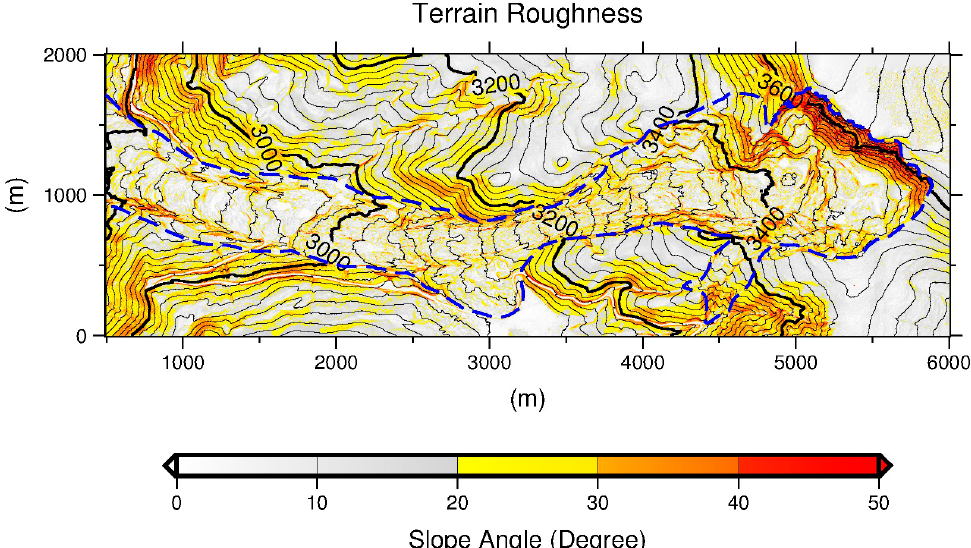
Figure 10. Map showing the elevation contours (in meters) and the terrain roughness (in degrees) derived from the DEM on 7 July 2015. The roughness is defined as the maximum surface slope over one square meter. The blue dashed line depicts the boundary of the landslide.